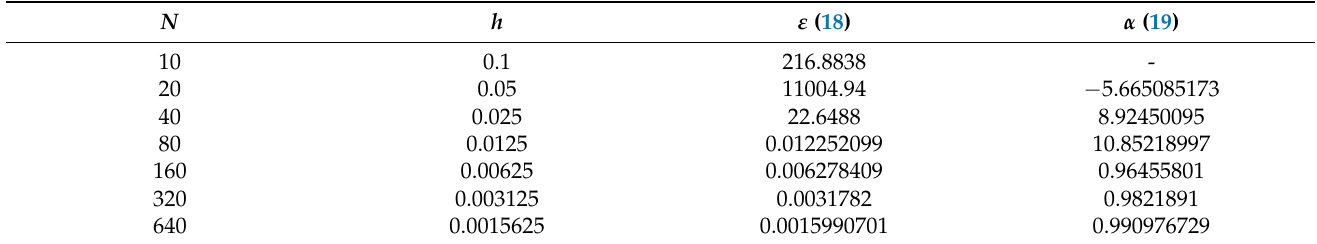
Table 2. Error and computational accuracy of the numerical scheme